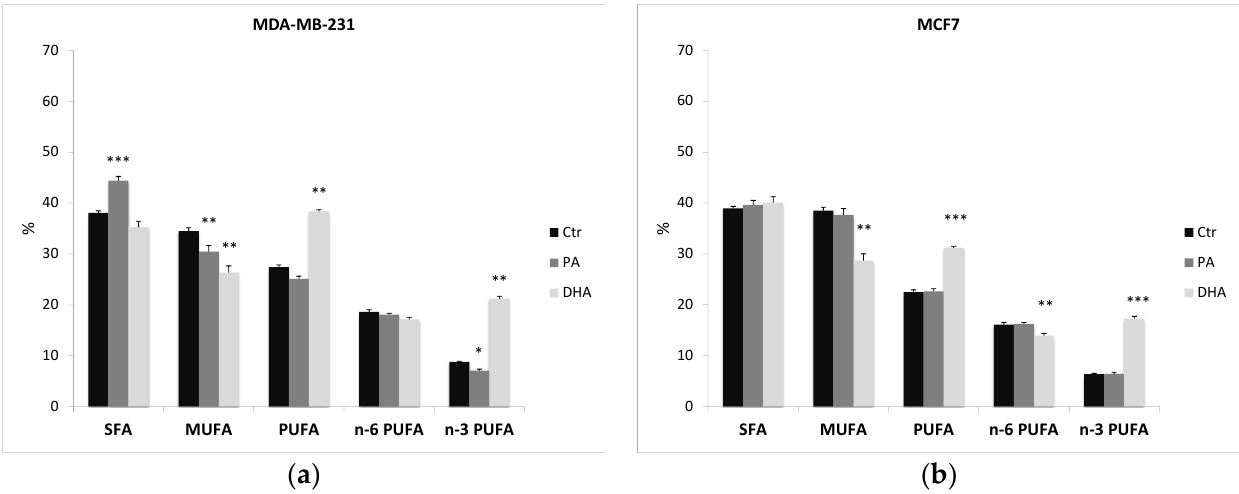
Figure 5. Percentage distribution of fatty acids from ER fractions purified from MDA-MB-231 ( a ) and MCF7 cells ( b ), treated with PA and DHA (50 µM) for 72 h: data are represented as mean ± SE of four independent experiments. (* p < 0.05, ** p < 0.01, and *** p < 0.001 vs. Ctr cells of the same line). SFA, saturated fatty acids; MUFA, monounsaturated fatty acids; PUFA, polyunsaturated fatty acids (=sum of n-6 and n-3 PUFA); n-6 PUFA, omega-6 polyunsaturated fatty acids; and n-3 PUFA, omega-3 polyunsaturated fatty acids.